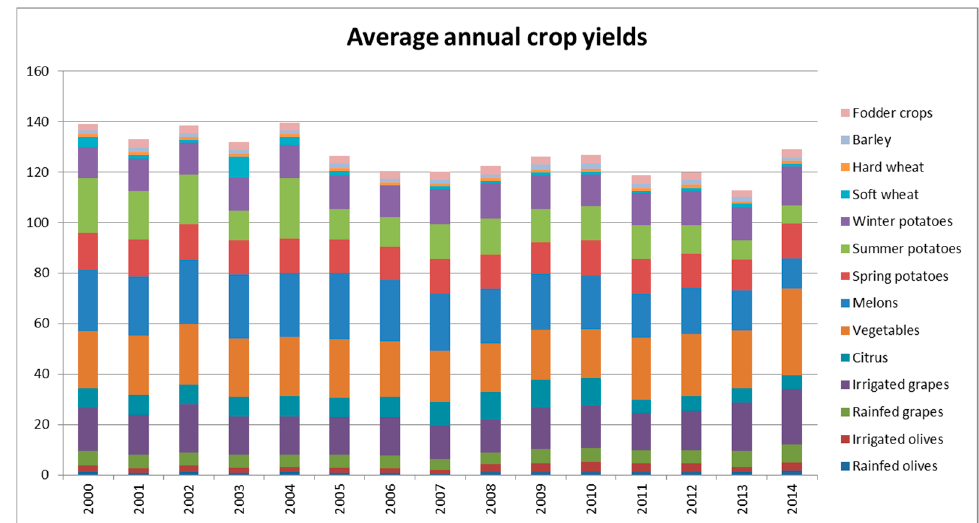
Figure 10. Average annual crop yields per year for the period 2000–2014 (t ha − 1 ).